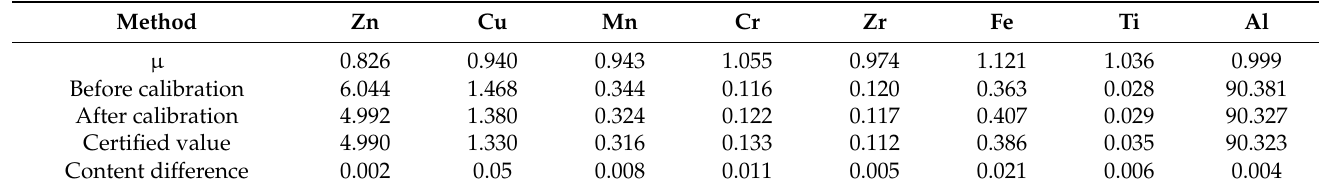
Table 4. The verification results of calibration method for the influence factor coefficient.